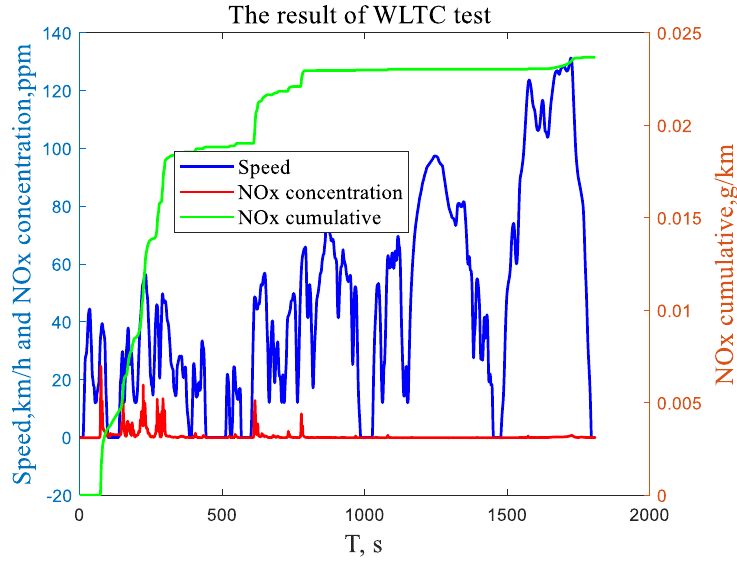
Figure 20. The results of WLTC test. Table 5. Emission test